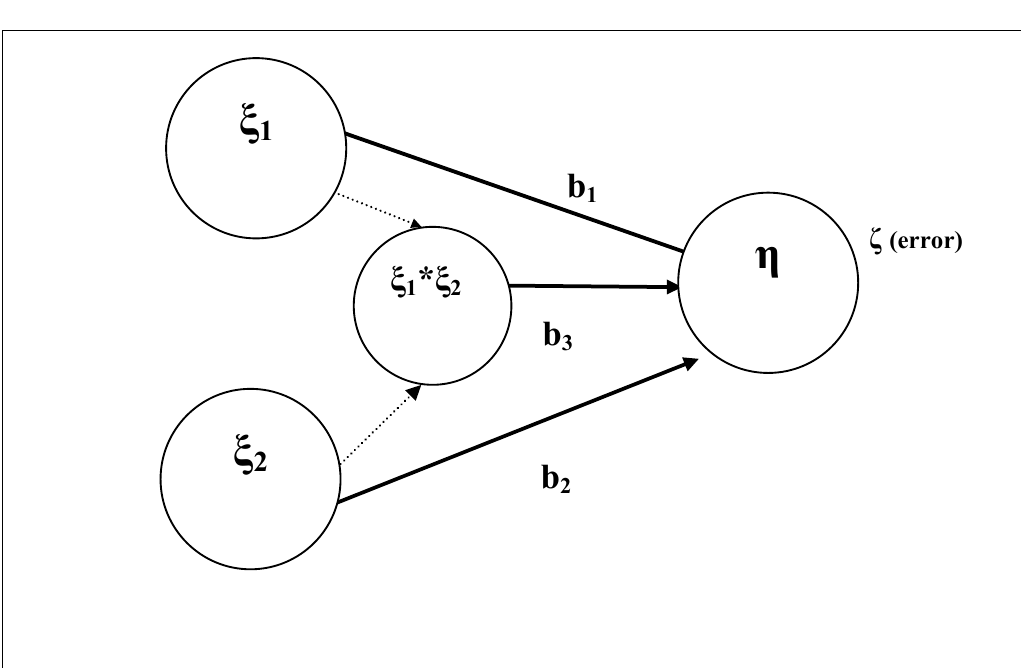
Figure 7: Mathematical representation of the conceptual